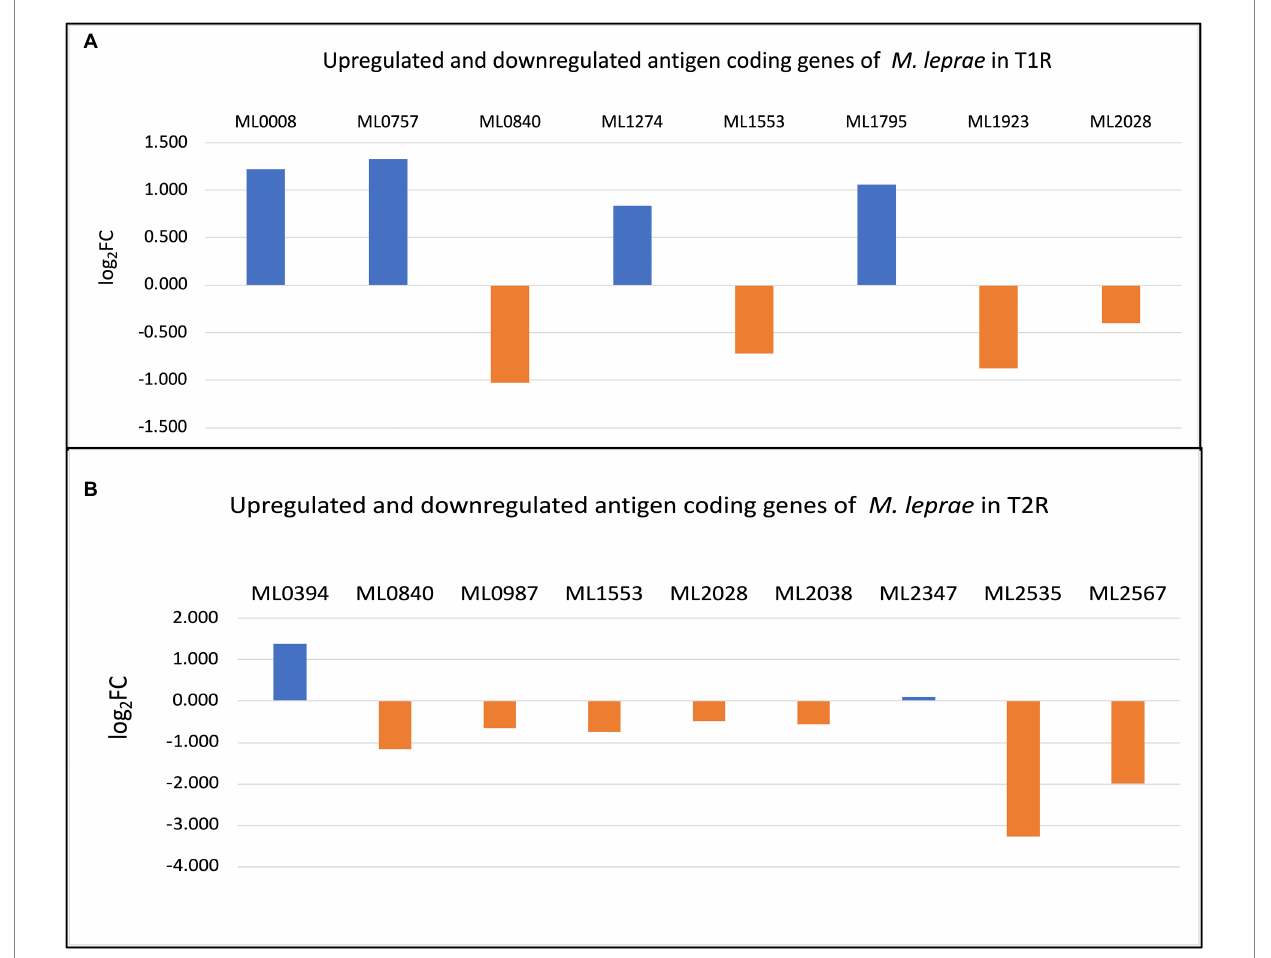
FIGURE 6 (A) Differentially expressed genes (DEGs) among antigen coding genes in T1R. (B) DEGs among antigen coding genes in T2R.